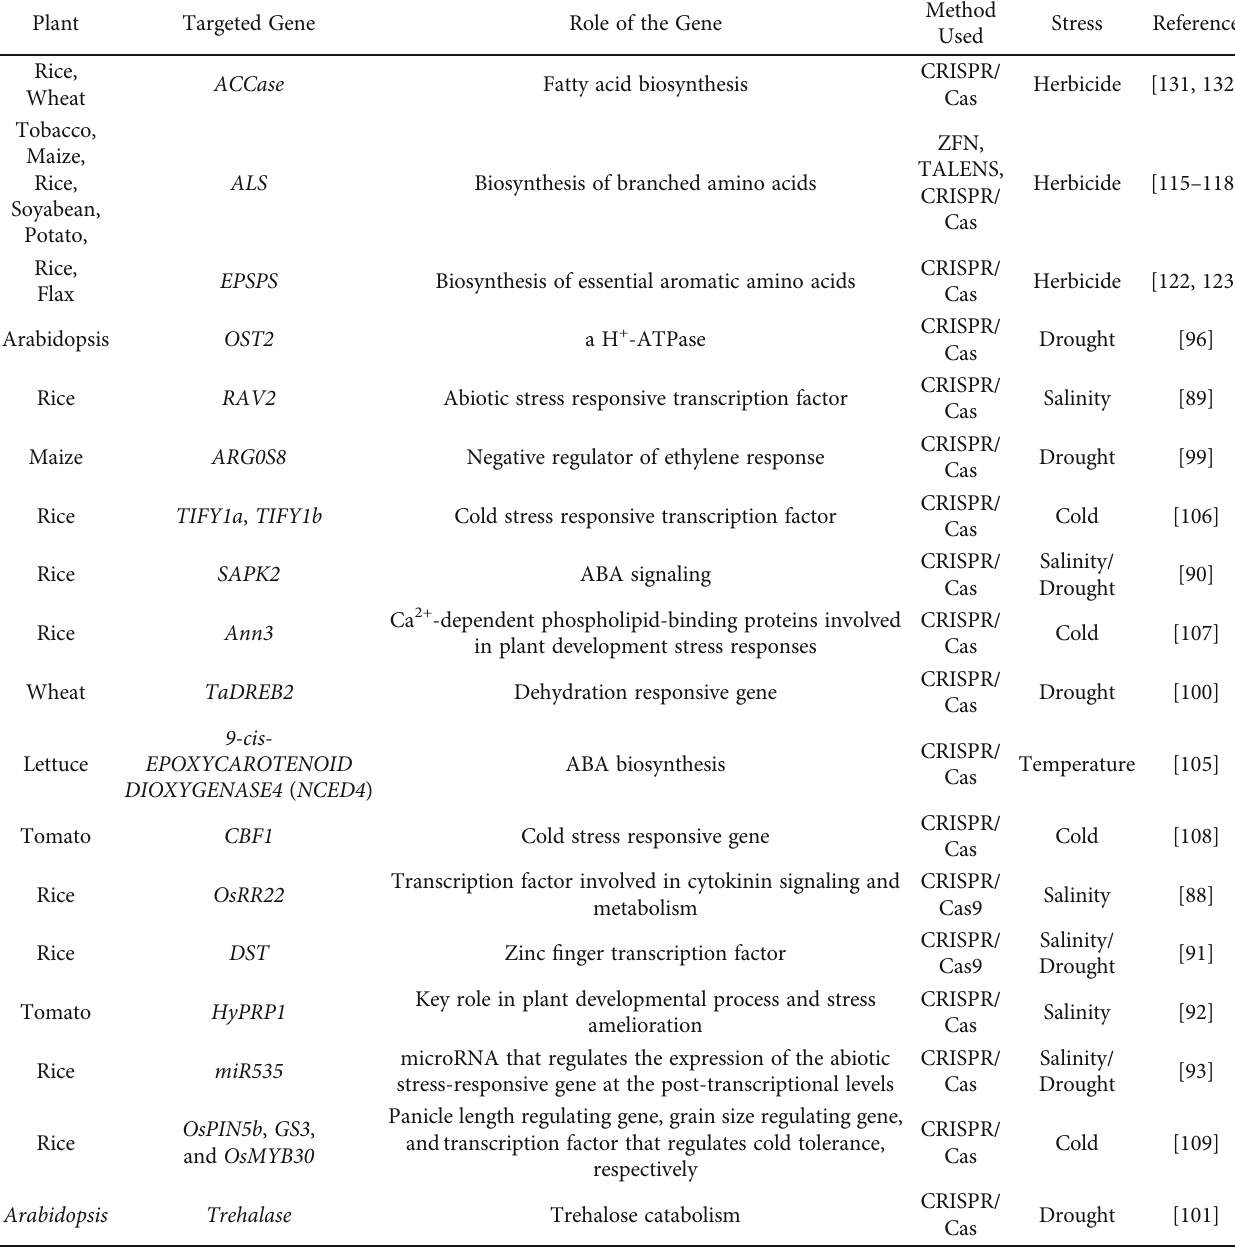
Table 2: Summary of the di ff erent genes used for achieving abiotic stress tolerance in plants using genome editing approach.